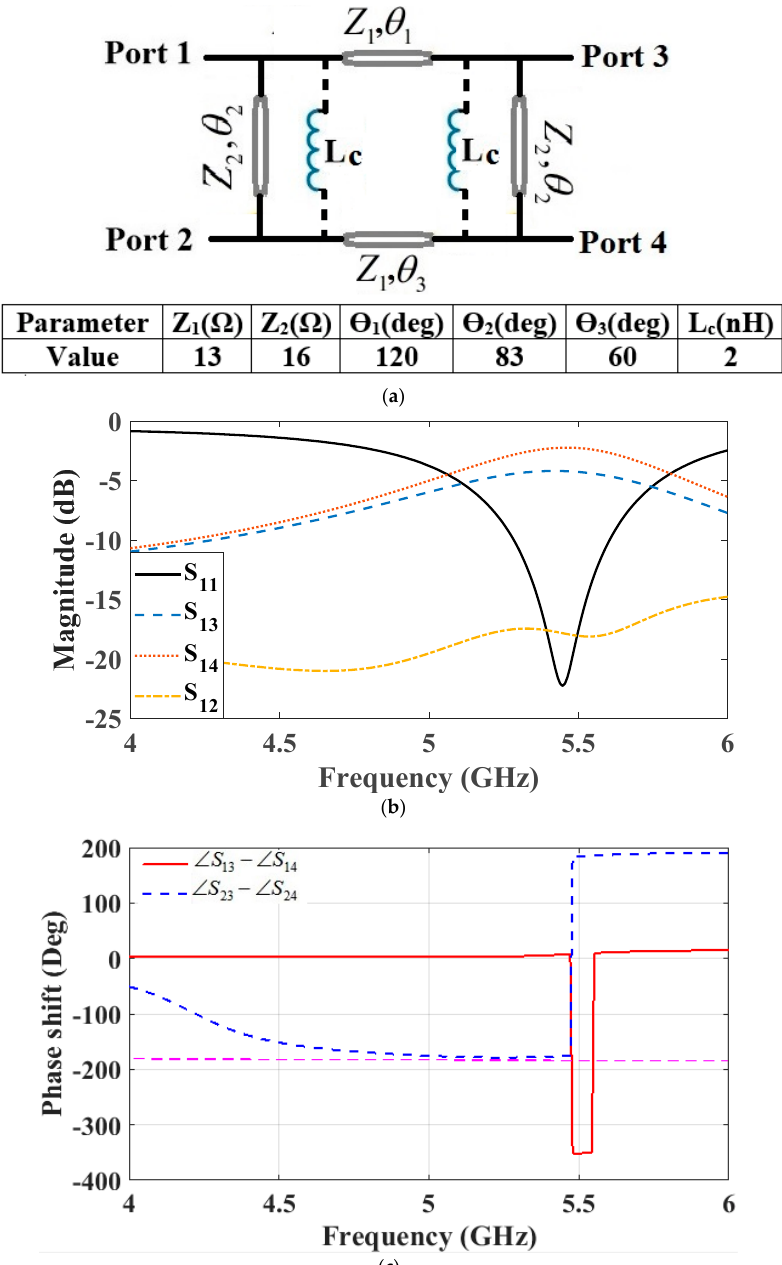
Figure 2. ( a ) The transmission line model of the proposed hybrid rat-race coupler, ( b ) the amplitude and ( c ) phase response of the proposed coupler.